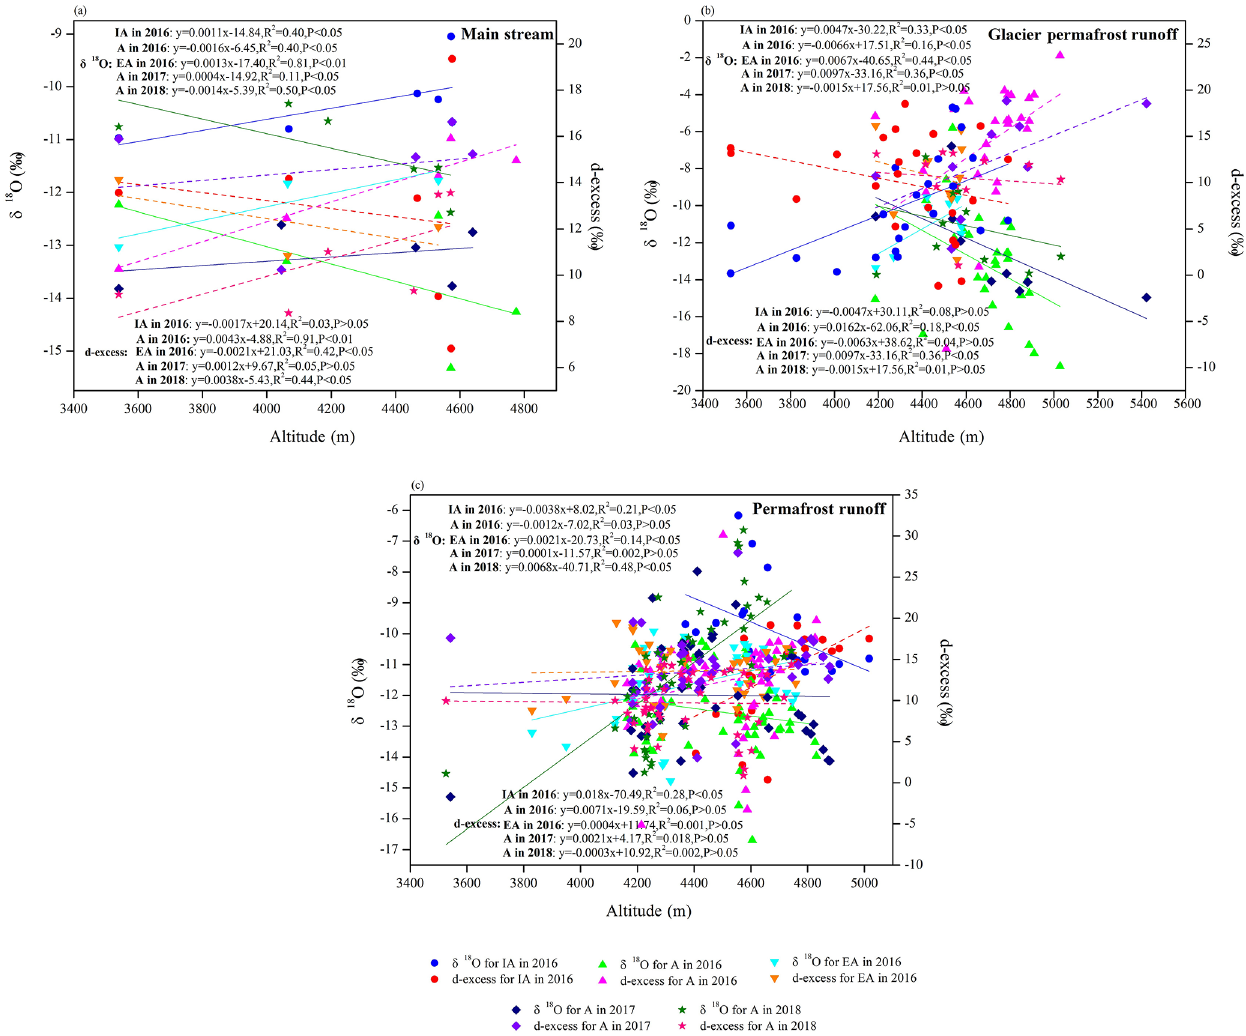
Figure 5. The variation in δ 18 O and d -excess with the altitude change in study area. ( a shows the variation in δ 18 O and d -excess with the altitude change for main stream; b shows the variation in δ 18 O and d -excess with the altitude change for river in glacier permafrost area; c shows the variation in δ 18 O and d -excess with the altitude change for river in permafrost area; IA in 2016 represents initial ablation in 2016; A in 2016 represents ablation in 2016; EA in 2016 represents end ablation in 2016; A in 2017 represents ablation in 2017; A in 2018 represents ablation in